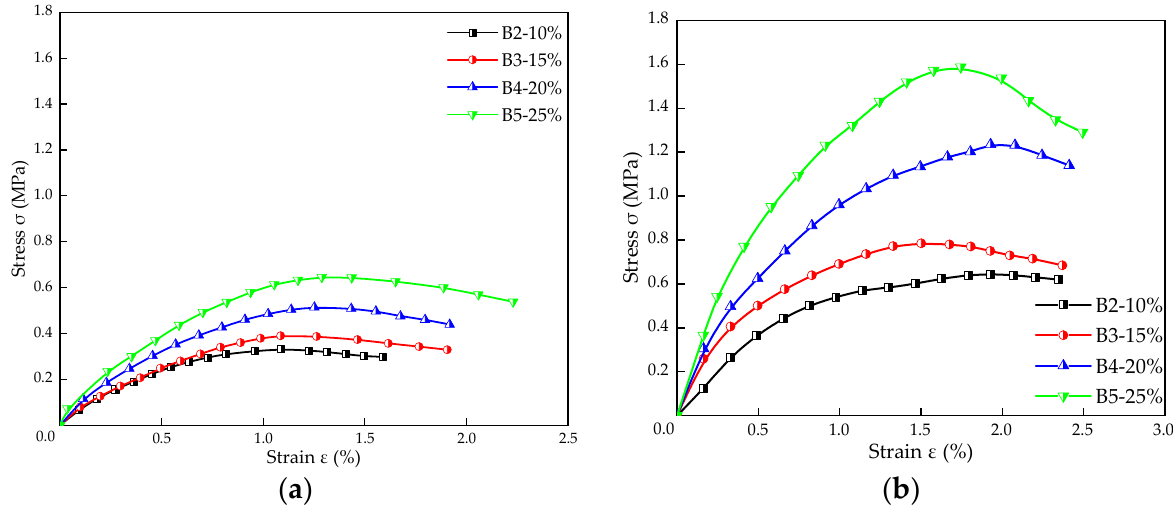
Figure 5. Stress–strain curves of stabilized silt with various TS dosages ( a ) 7 days of curing, ( b ) 28 days of curing.